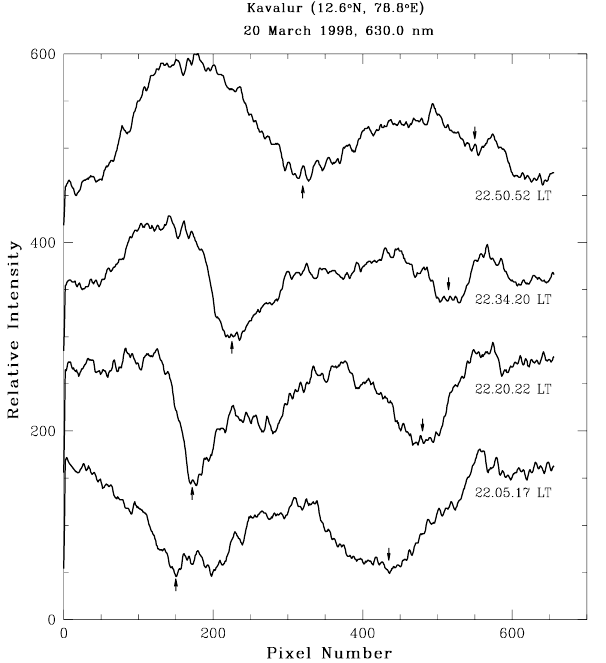
Fig. 8. Variation in the relative intensity of 630nm along an east– west band ( ± 8 pixels) passing through the center of the image (i.e. the local zenith) in four images taken over Kavalur at approximately 15 min intervals on the night of 20/21 March 1998. Upward and downward arrows show eastward movement of two plasma deple- tions.